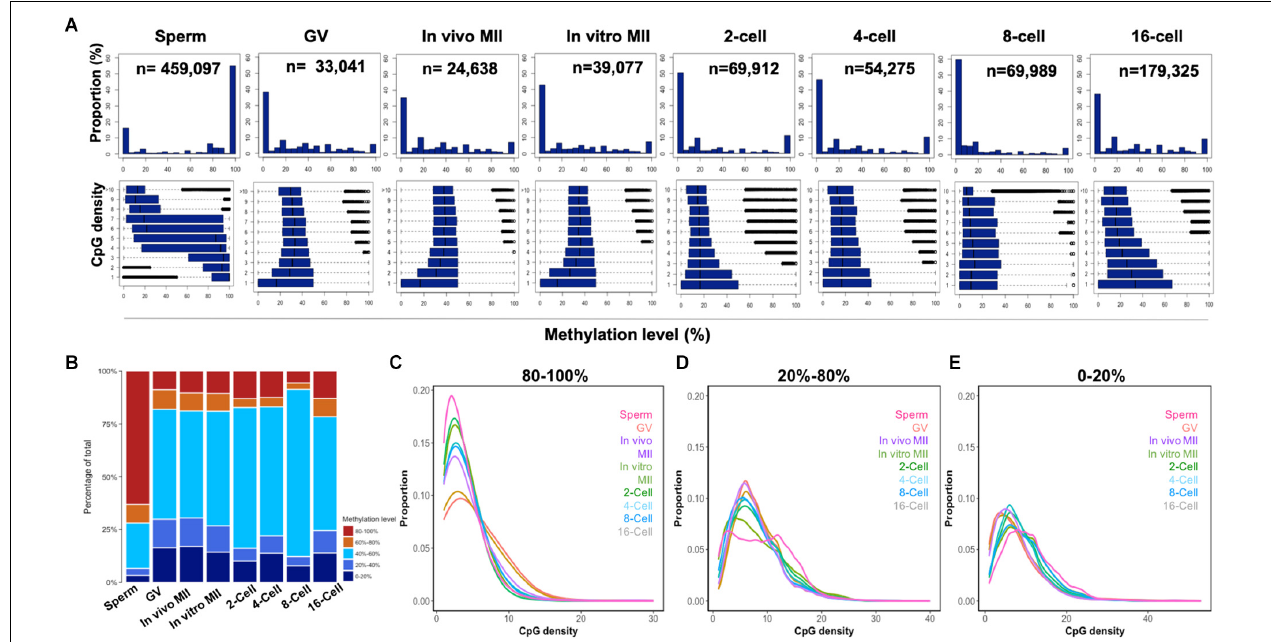
FIGURE 2 | CpG density and the methylome dynamics of bovine gametes and pre-implantation embryos. Histogram (A) of the percentages of 300-bp tiles with different DNA methylation levels at each development stage (upper panels). Box plots of methylation levels across different CpG densities at each stage (bottom panels). Stack bar plot (B) of the percentages of tiles with high (80–100%), intermediate (60–80%; 40–60%, and 20–40%), and low (0–20%) methylation levels. The distribution of high (C) , intermediate (D) , and low (E) methylation tiles against CpG densities at each stage. GV, germinal vesicle oocytes; MII, matured